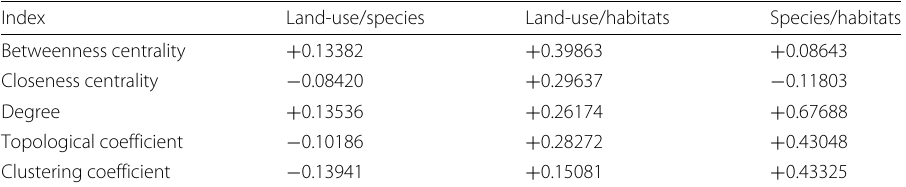
Table 7 Spearman correlation of various complex network indices, between pairs of similarity-based graphs